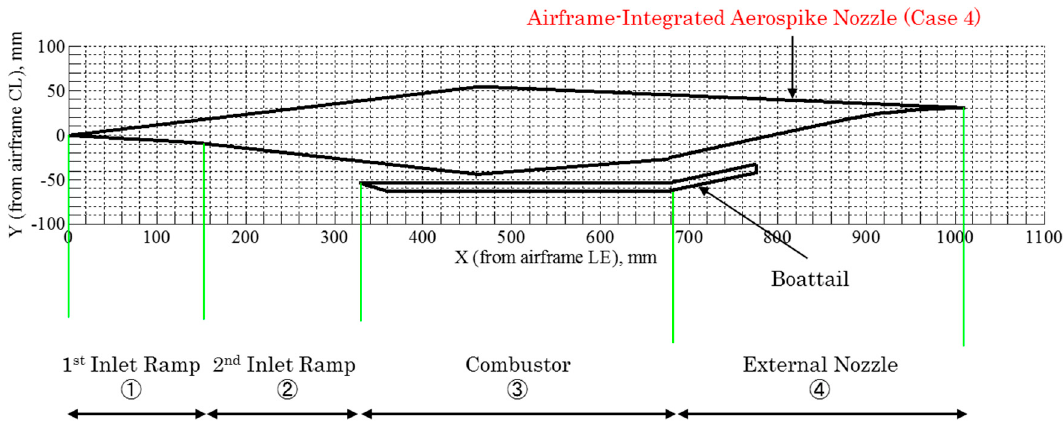
Figure 5. Flow separation limit of external flow on the boattail.